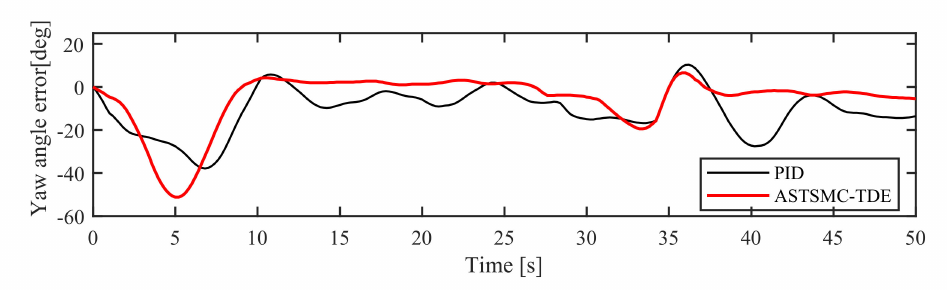
Figure 27. The experimental yaw angle error in AM